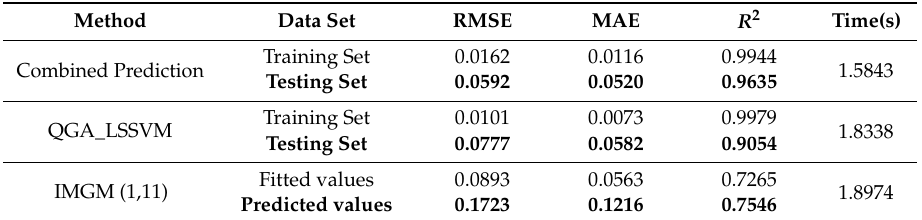
Table 14. The forecasting evaluation indexes of the current